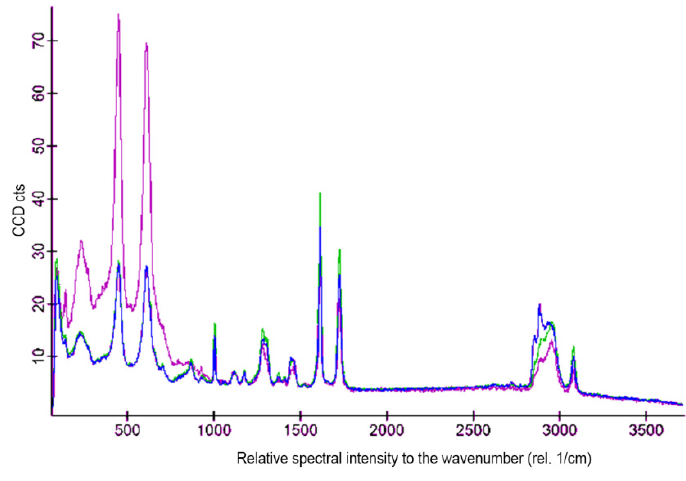
Figure 8. Average spectra corresponding to colored areas in X – Z from Figure 7.